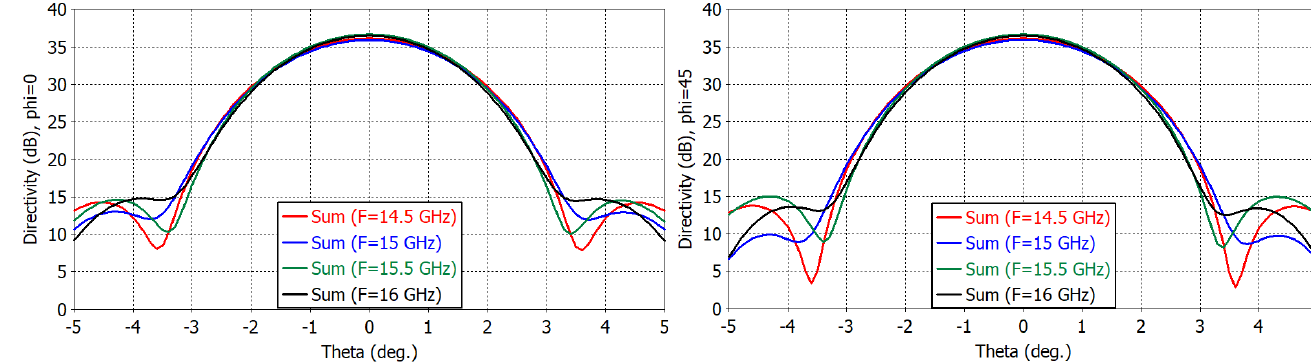
Figure 15. Sum channel directivity patterns of the reflector antenna.